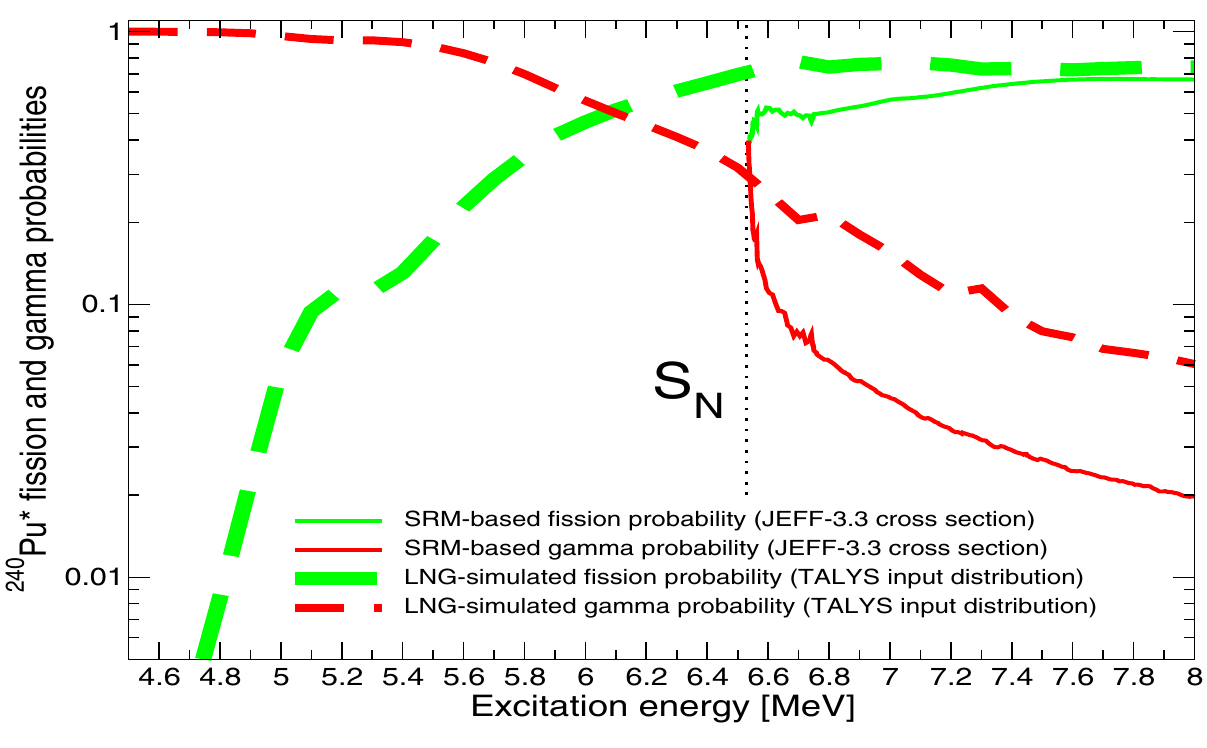
Figure 2. (Color online) Fission and γ probabilities according to the 240 Pu( α, α ′ f ) 240 Pu ∗ and 240 Pu( α,α ′ γ ) 240 Pu ∗ reactions as a function of excitation energy. The neutron emission threshold ( S n ) quoted provides the neutron-scaled baseline (dotted vertical line). SRM-based estimates are represented by thin solid curves to be compared to our reference simulation (present work; thick dashed